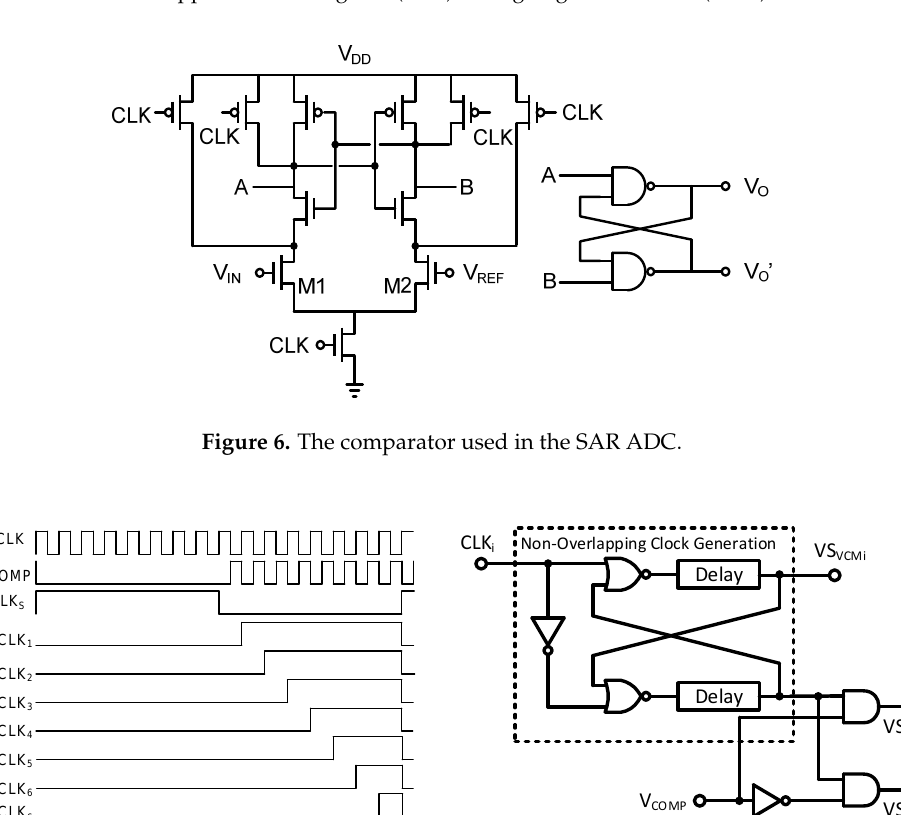
Figure 7. ( a ) Clock timing; ( b ) Clock generating logic.